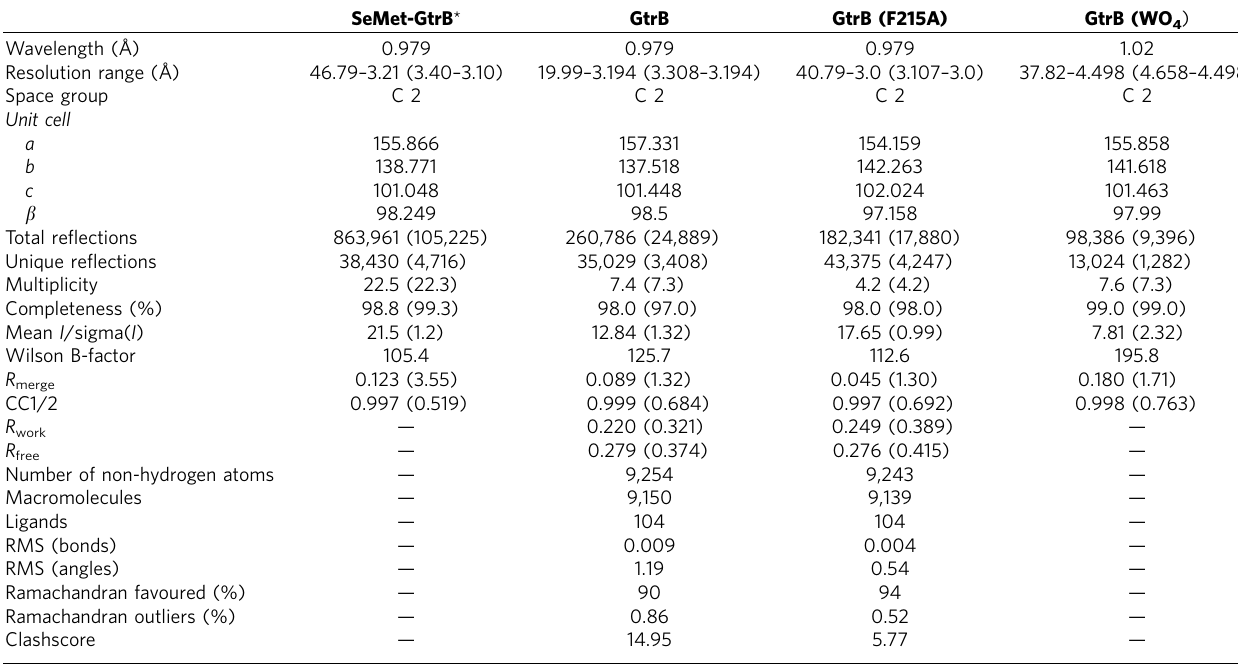
Statistics for the highest resolution shell are shown in parentheses. *Friedel pairs (I þ /I (cid:2) ) treated as separate reflections; RMS, Root mean